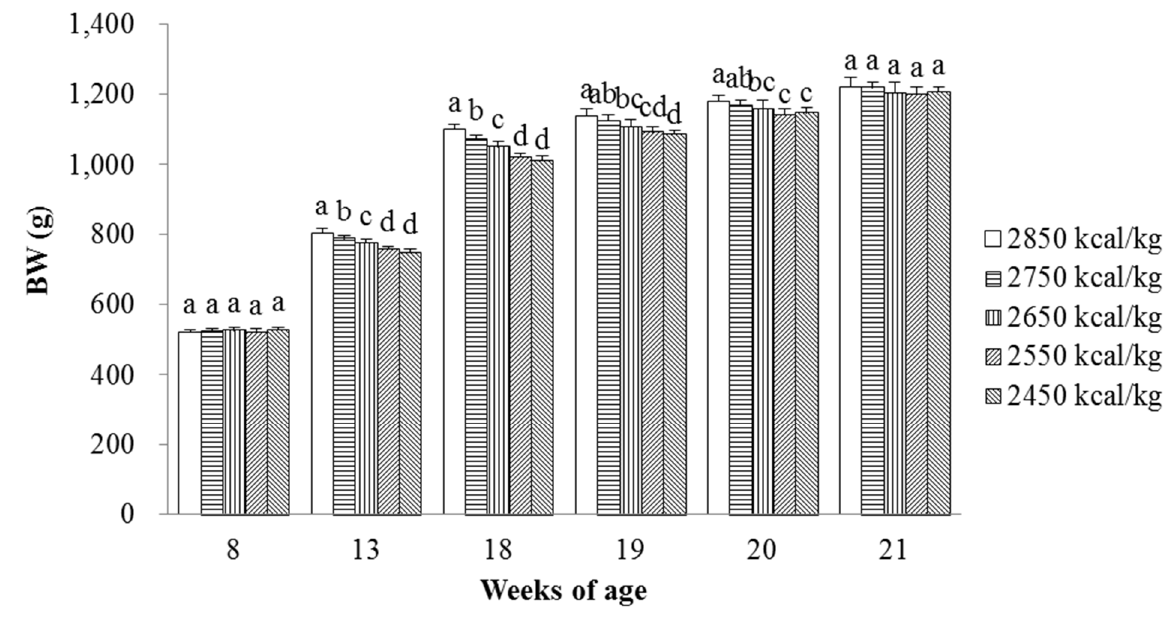
Figure 1. Effects of energy-restricted feeding and switching to ad libitum feeding on the BW of pullets from 8 to 21 weeks of age. Values are means of eight replicates per dietary treatment. Columns with different superscripts (a–d) are significantly different at p < 0.05.